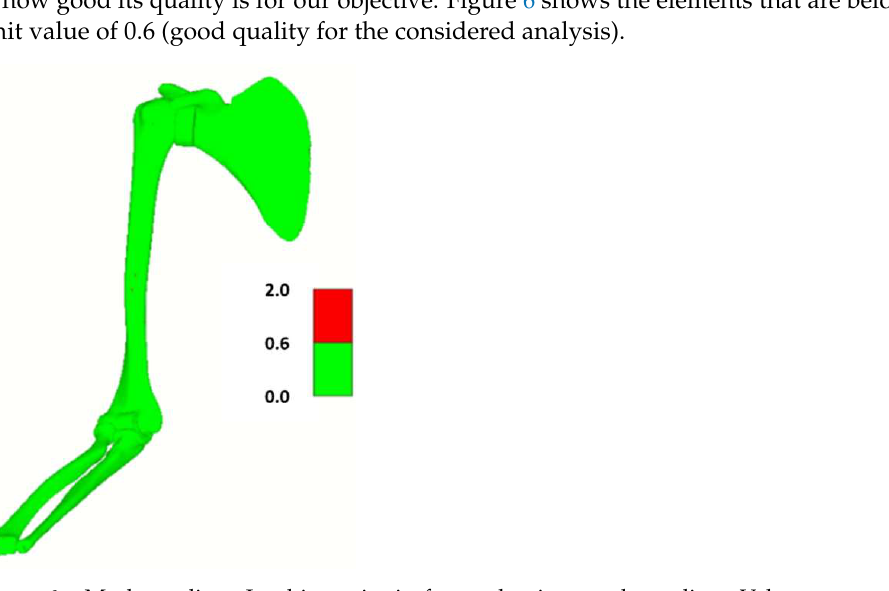
Figure 6. Mesh quality. Jacobian criteria for evaluating mesh quality. Value represented is (1-measured value on element/ideal value on element). Maximum threshold defined as 0.6.